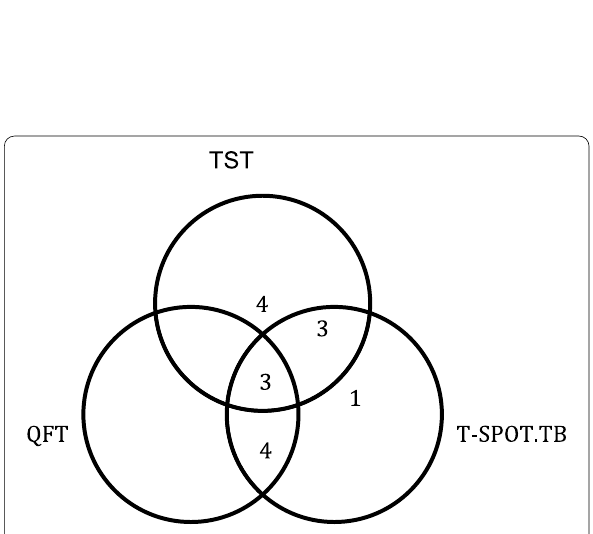
Fig. 2 Agreement among tests for LTBI